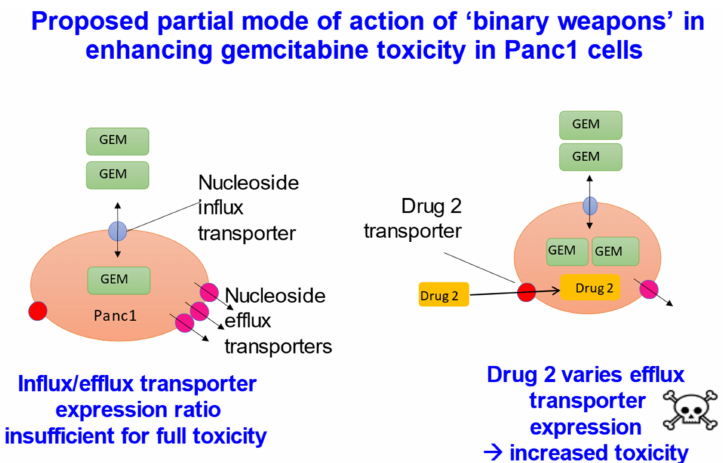
Figure 7. “Binary weapons” based on drug transporters [294]. The cytotoxic drug gemcitabine (GEM, a fluorinated cytosine nucleoside analogue) when added at a certain low concentration to Panc1 pancreatic cancer cells was barely cytotoxic (left panel). However, when a second drug was added, which was itself also non-toxic, the combination was substantially more toxic. What had occurred was that, in response to the GEM, the cells had increased the expression of the efflux transporter ABCC2 (MRP2) some 12-fold; the second drug inhibited this process, and in a cell-selective